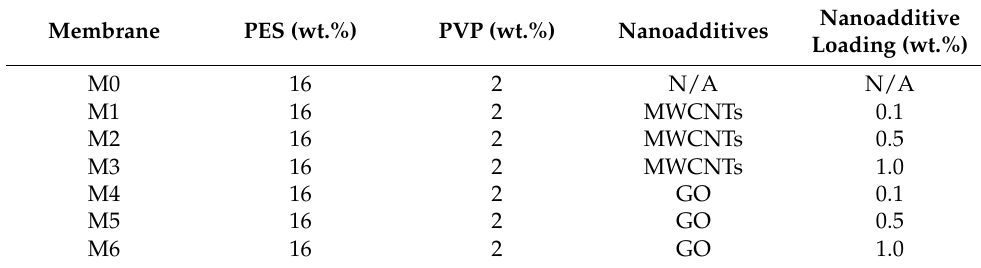
Table 1. Composition of casting solutions of PES UF membranes.